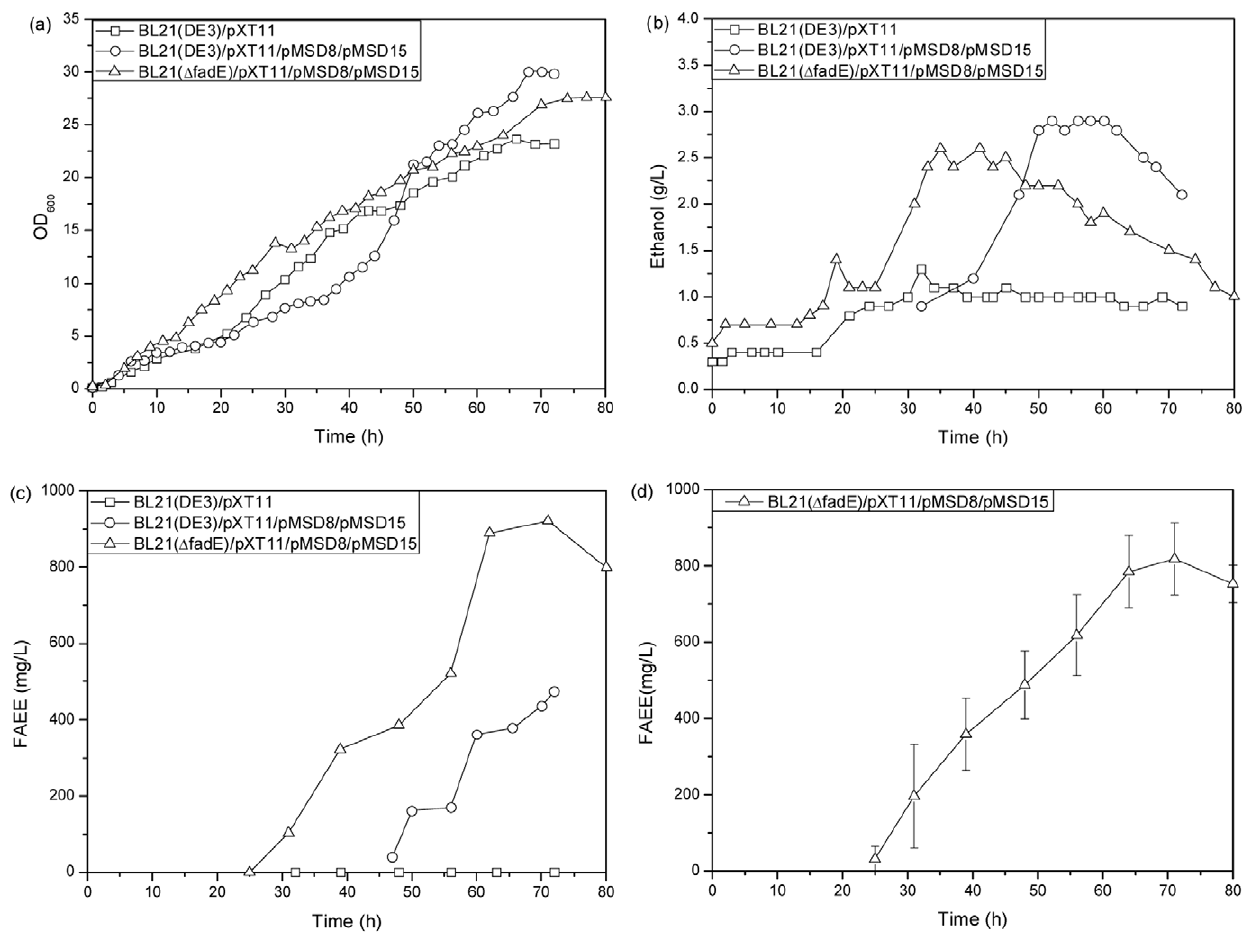
Figure 2. Analysis on fed-batch fermentations under the optimized conditions described in Materials and Methods. (a) Cell growth, (b) Ethanol production, (c) FAEE production of three E. coli mutant strains, BL21 (DE3)/pXT11 and BL21 (DE3)/pMSD8/pMSD15/pXT11 and BL21 ( D fadE)/pMSD8/pMSD15/pXT11. (d) Three paralleled experiments for FAEE production of the strain BL21 ( D fadE)/pMSD8/pMSD15/pXT11.